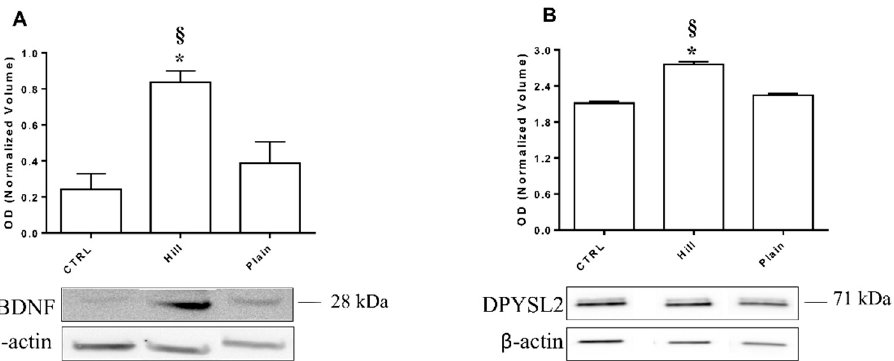
Figure 8. WB analysis of BDNF ( A ) and DPYSL2 ( B ) expression in SH-SY5Y cells treated with and without EVOO extracts. Representative immunoblot images and histograms of band normalized OD are shown. Data are presented as mean ± SEM of three independent experiments. Data were analyzed with a one-way ANOVA followed by the Bonferroni’s test. * p < 0.05 vs. CTRL; § p < 0.05 vs. plain.